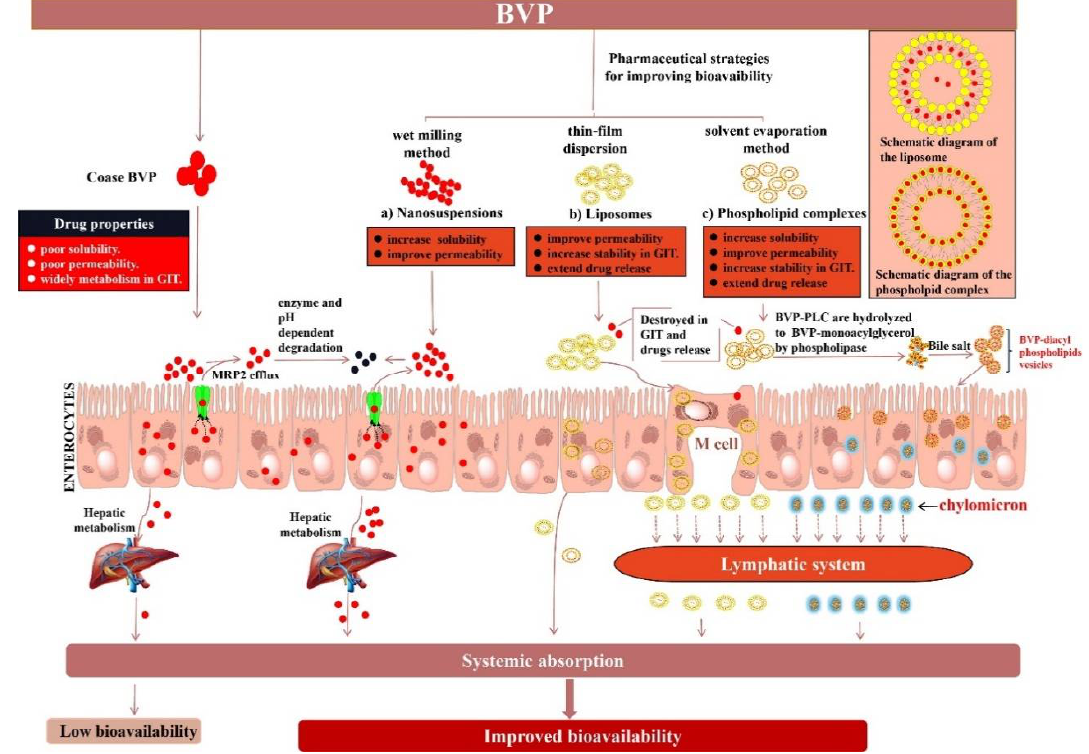
Figure 2. The outline of this paper and the mechanism of Breviscapine–nanosuspension (BVP–NS), BVP–liposomes (LP) and BVP–phospholipid complexes (PLC) to enhance bioavailability.